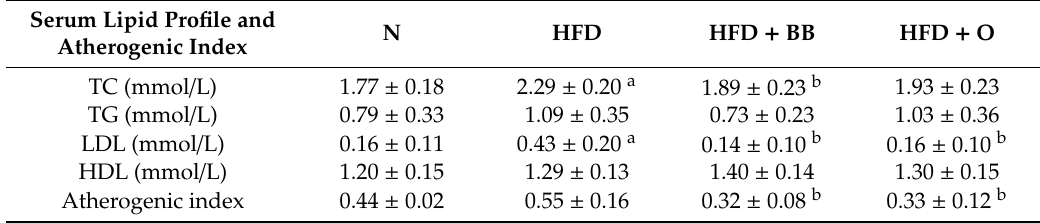
Table 4. The e ff ects of bee bread on serum lipid profiles and the atherogenic index. Serum Lipid Profile